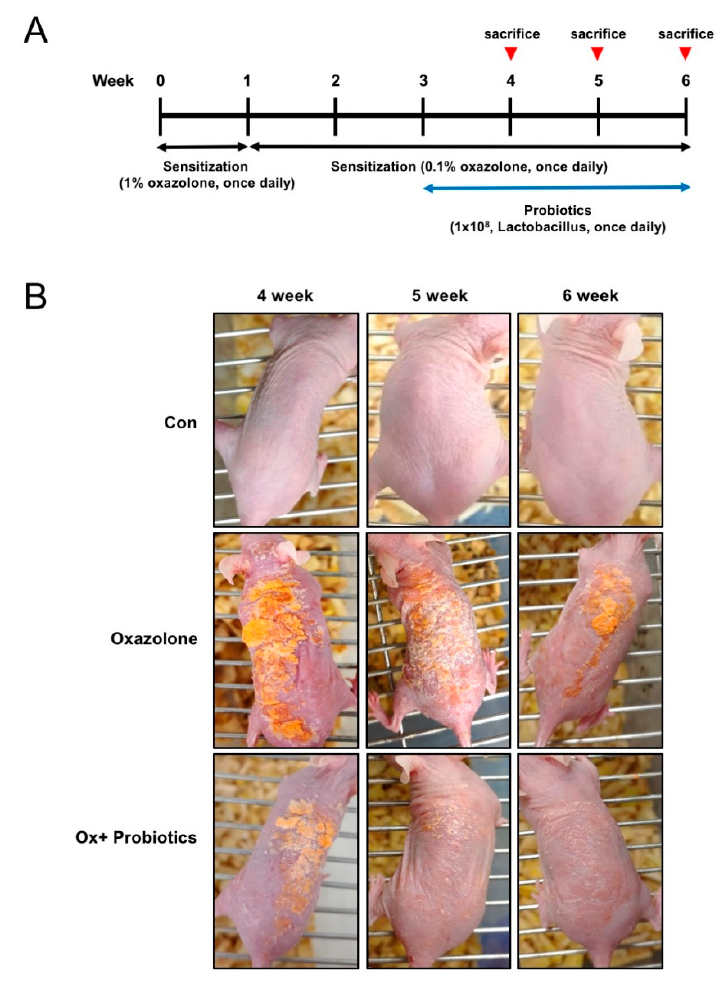
Figure 1. E ff ects of probiotics on the development of an Ox-induced atopic dermatitis (AD) mouse model. ( A ) Schematic representation of the experiment. Development of Ox-induced AD mouse model with multiple features of AD. ( B ) Clinical features of AD skin lesions. Con, control mice; Ox, oxazolone; Ox + Probiotics, Ox-induced AD mice with probiotics treatment. Two independent experiments were performed, and at least three mice per group were used in each experiment.